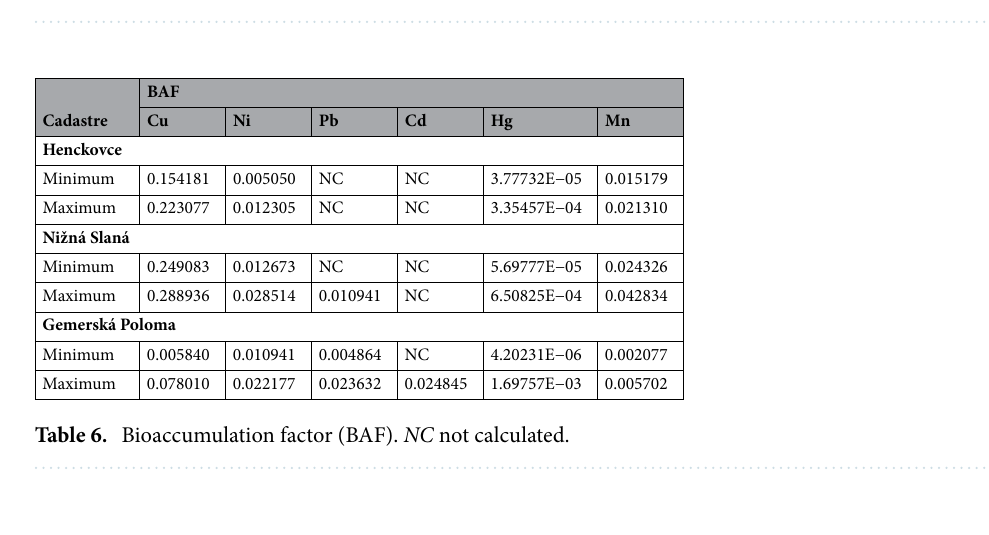
Table 5. The contents of risk elements (Cu, Ni, Pb, Cd, Hg, Mn) in plants (mg/kg DM). DM dry matter, BDL below detection limit, NC not calculated. *Content of Hg expressed as μg/kg DM. a,b,c Statistically significant differences between cadastres, P value < 0.05.